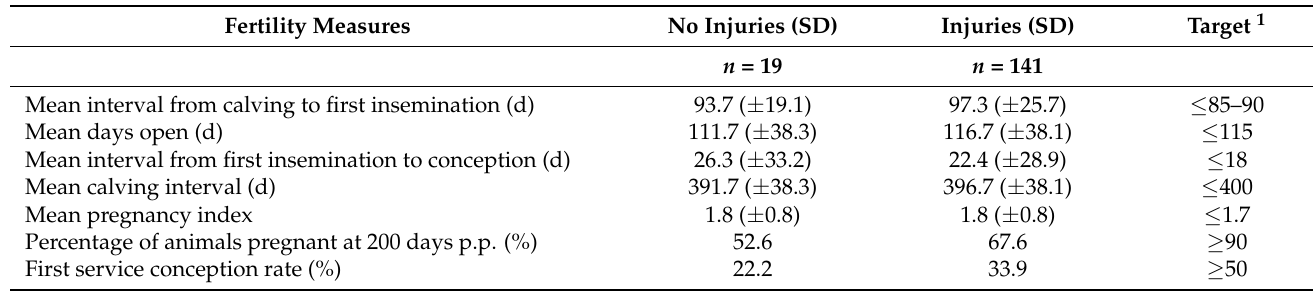
Table 6. Fertility measures in heifers with and without injuries of the vestibulum vaginae and/or the vagina (SD = standard deviation).